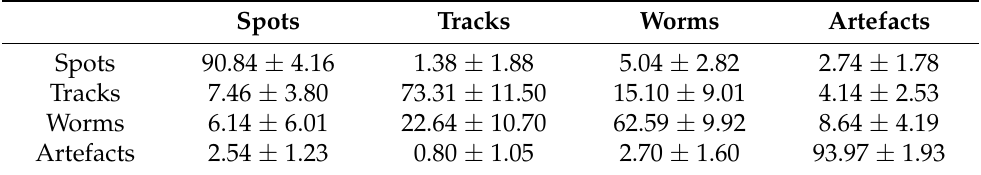
Table 3. Confusion matrix of the network with input convolutional VGG16 architecture.